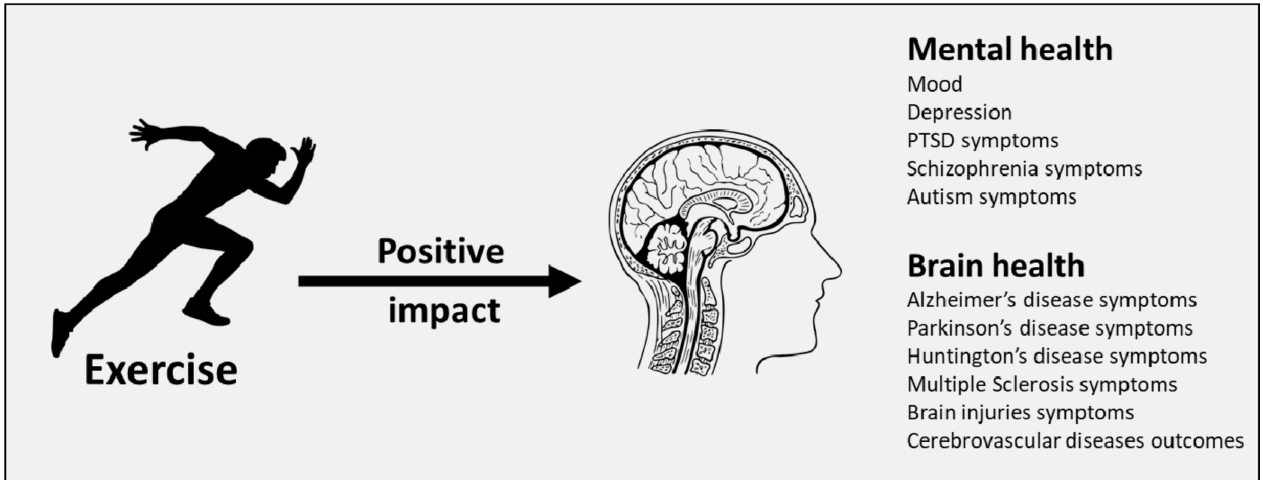
Figure 1. Impact of exercise on mental and brain